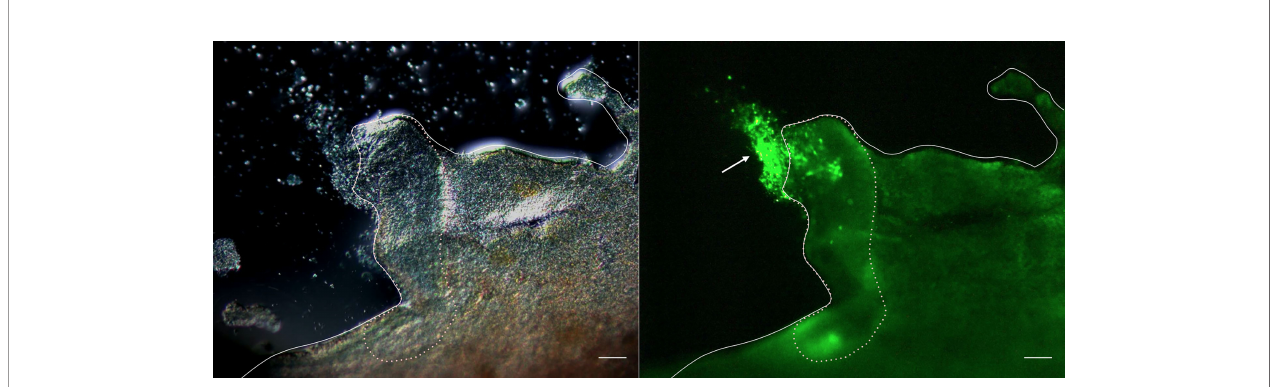
FIGURE 1 | Fluorescence microscopy of the cleavage site of the intestine. Images taken 3 h after autotransplantation of labeled coelomocytes to the eviscerated animal. Left panel: Differential interference contrast. Right panel: Image showing the fl uorescence. Full line: Serosa. Dotted line: Cleavage site. ! : cellular aggregates. Scale bars = 200